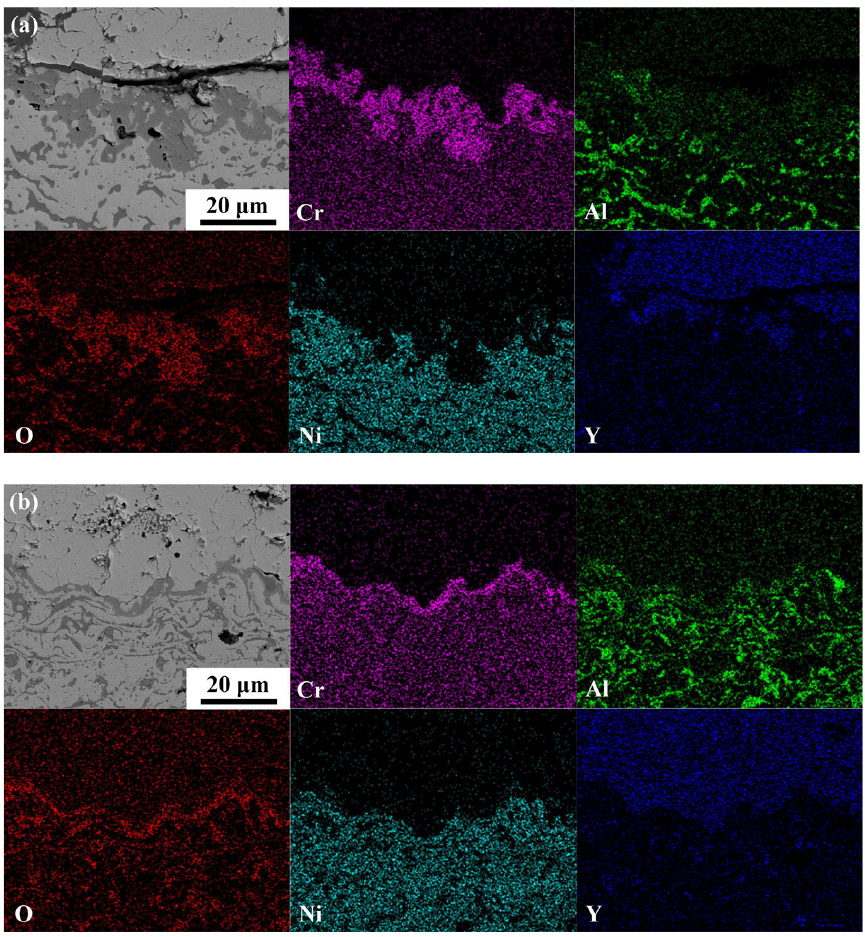
Figure 11. Cross-sectional morphologies of TGO interface and the corresponding EDS mapping results of Cr, Al, O, Ni, and Y elements: ( a ) cracked interface; ( b ) uncracked interface.